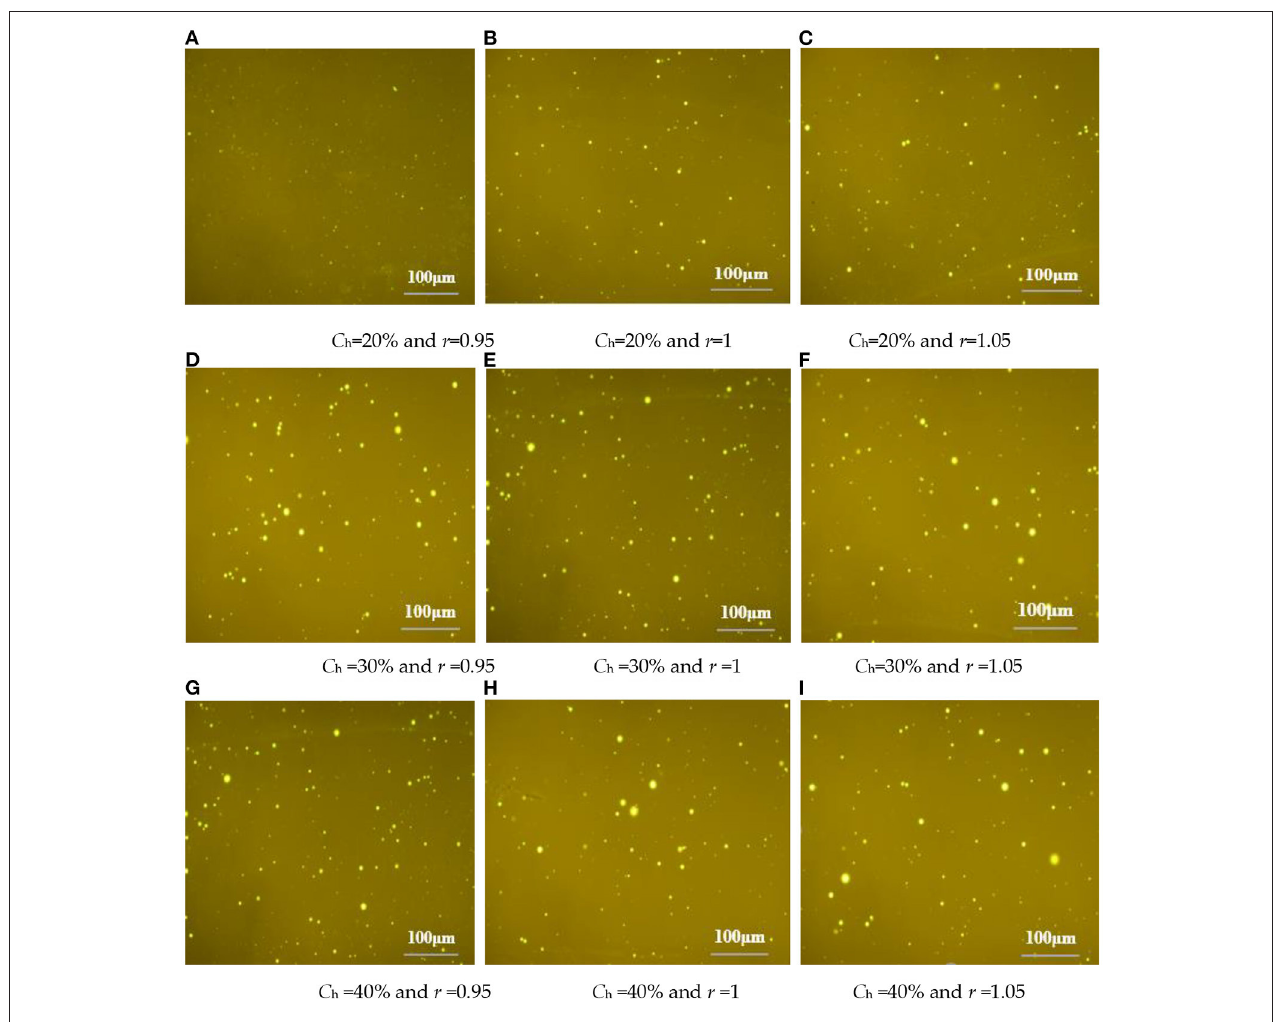
FIGURE 19 | Fluorescence micrographs of polyester-based TPU-modified asphalt. (A) C h = 20% and r = 0.95. (B) C h = 20% and r = 1. (C) C h = 20% and r = 1.05. (D) C h = 30% and r = 0.95. (E) C h = 30% and r = 1. (F) C h = 30% and r = 1.05. (G) C h = 40% and r = 0.95. (H) C h = 40% and r = 1. (I) C h = 40% and r =